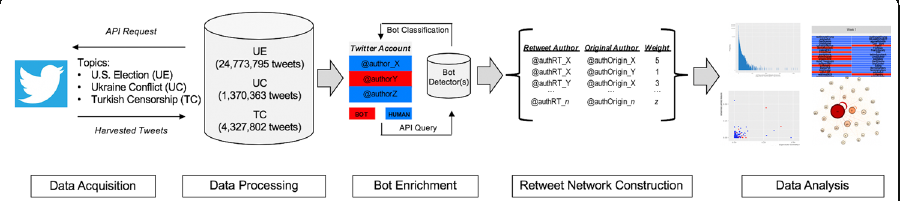
Fig. 1 Social bot analysis methodological framework overview depicting processes required to transform data to enable comparative analysis. For the example use cases of this study, we focus on OSN conversation data associated with three global events in 2016: the 2016U.S. Election (UE), the Ukraine Conflict (UC) and Turkish Censorship